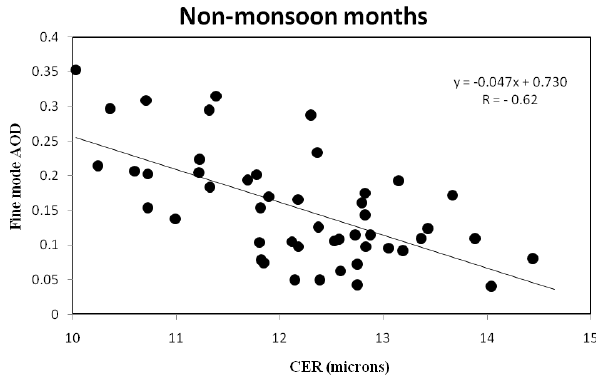
Fig. 3. Scatter plot between fine mode AOD and CER indicating a negative correlation in non-monsoon months. 9